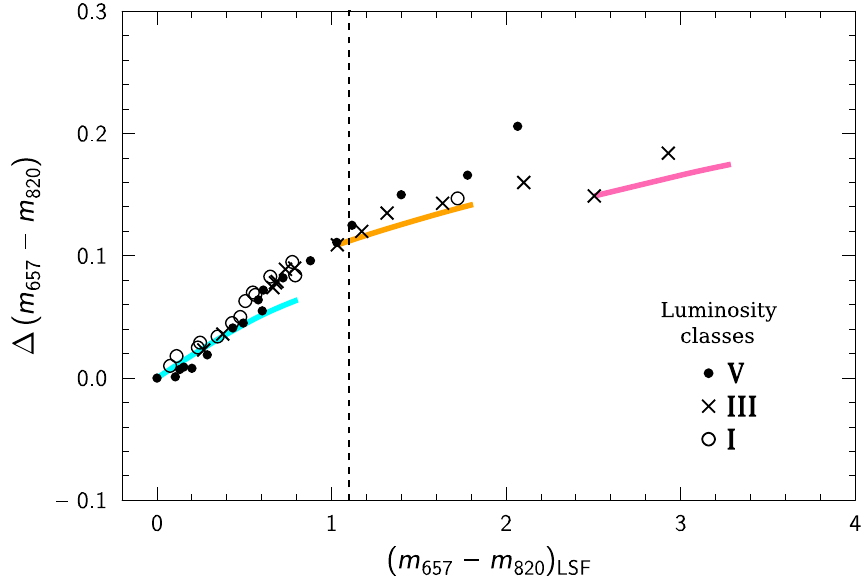
Fig. 10a. Decontamination corrections for color indices simulated from the Gaia RP spectra plotted as a function of the contaminated ‘color index’ m 657 – m 820 . Reddening lines for the stars O8 V, K5 III and M5 III up to A V = 3 mag are shown. The vertical broken line separates M-type stars from the remaining without interstellar reddening.